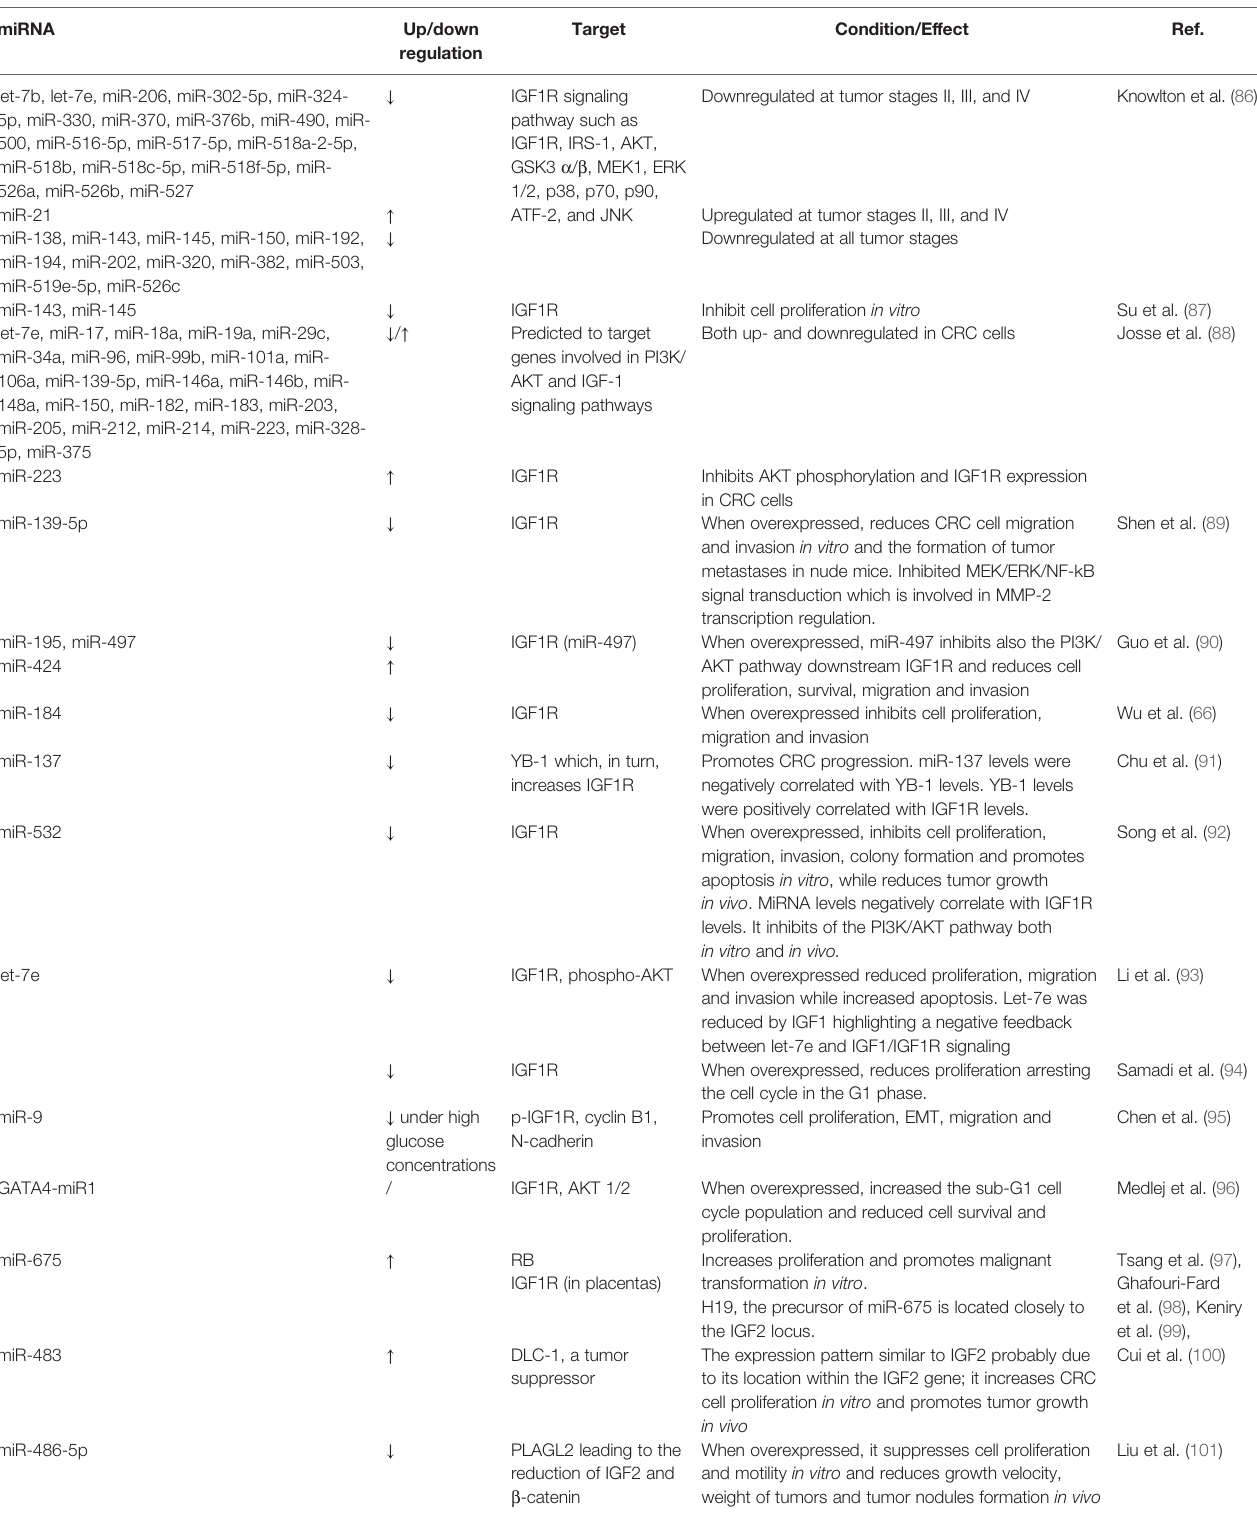
TABLE 3 | Current knowledge on the role of miRNAs and lncRNAs on the GH/IGF1 axis and IGF system in colorectal cancer. miRNA Up/down Target Condition/Effect regulation